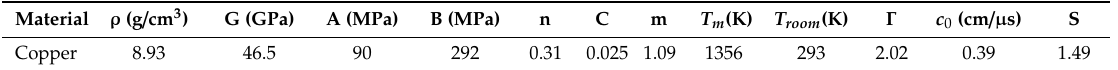
Table 3. Material parameters for Copper.